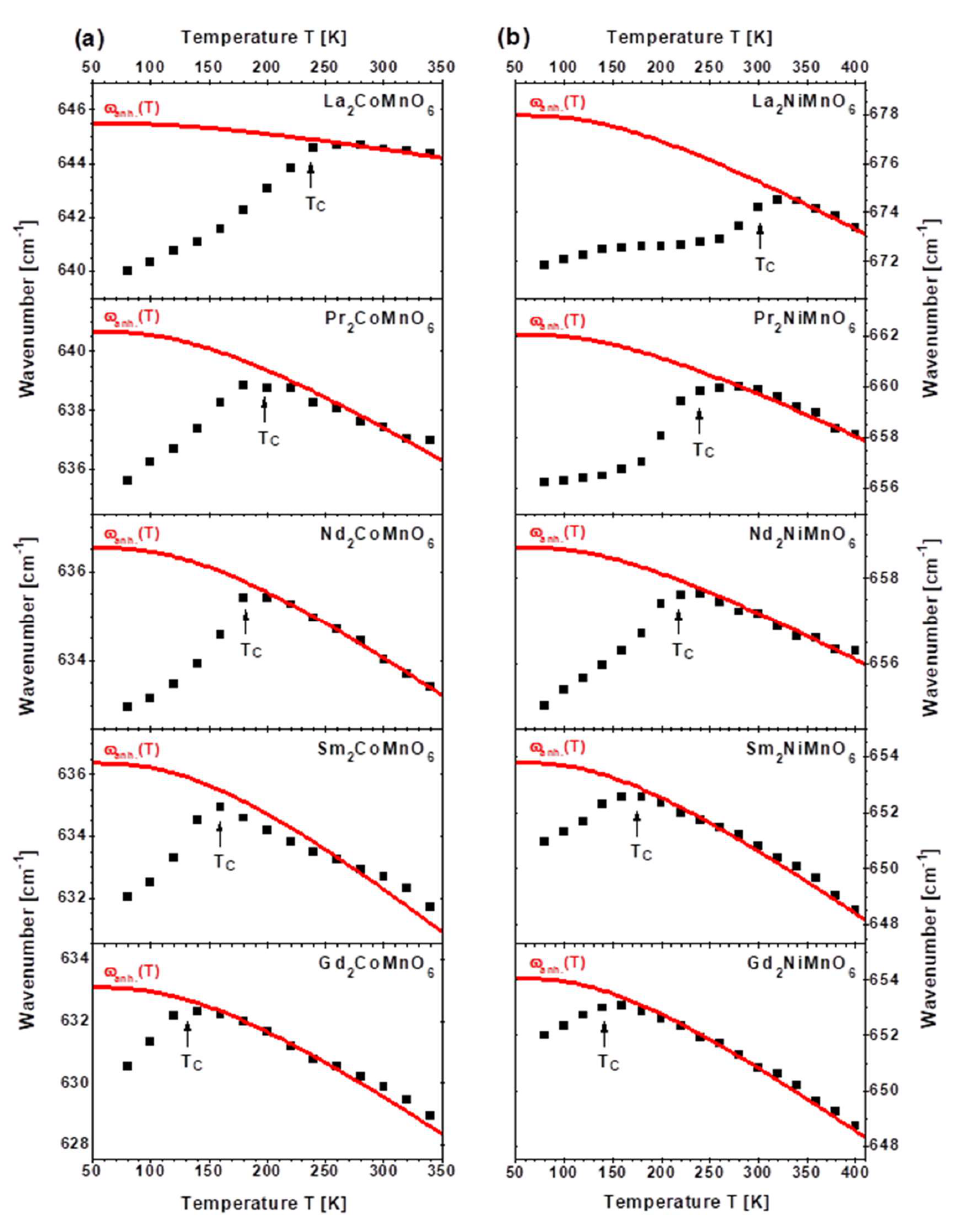
Figure 3. Temperature dependence of the A g breathing mode position in the A 2 CoMnO 6 ( a ) and the A 2 NiMnO 6 ( b ) thin A 2 NiMnO 6 ( b ) thin film series (thickness d ~ 100 nm) with A = La, Pr, Nd, Sm, and Gd on STO(111) film series (thickness d~100 nm) with A = La, Pr, Nd, Sm, and Gd on STO(111) in the Raman spectra (unpolarized). The red solid lines denote the approximation from the anharmonic three-phonon model, which fits nicely for T > T C in the paramagnetic phase of the films.